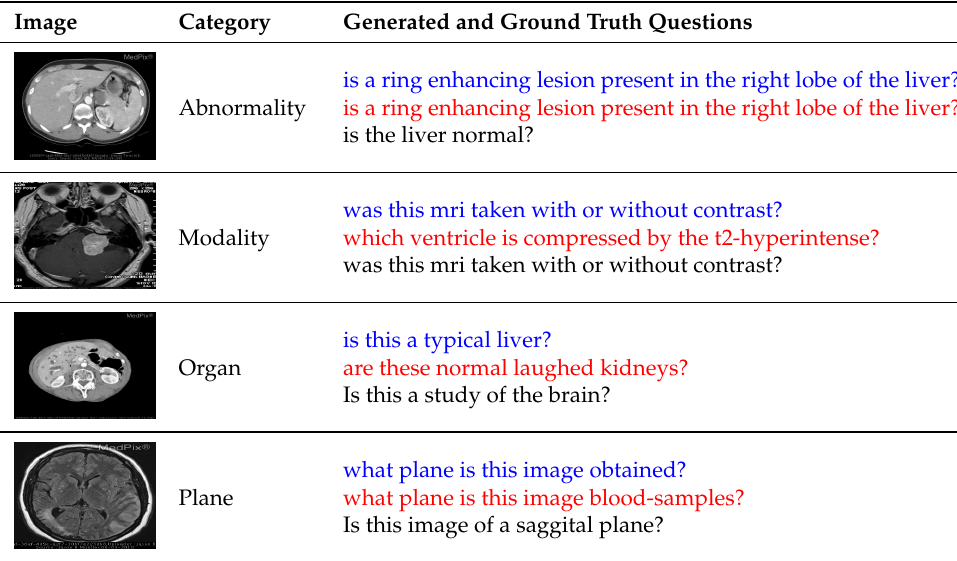
Table 6. Example image along with the question category, the automatically generated questions, and the ground truth question. The generated questions by our VQGRaD model and the baseline system are shown in blue and red, respectively. We manually selected the baseline’s question from its outputs as the baseline system does not recognize the question category and generates a random question for each